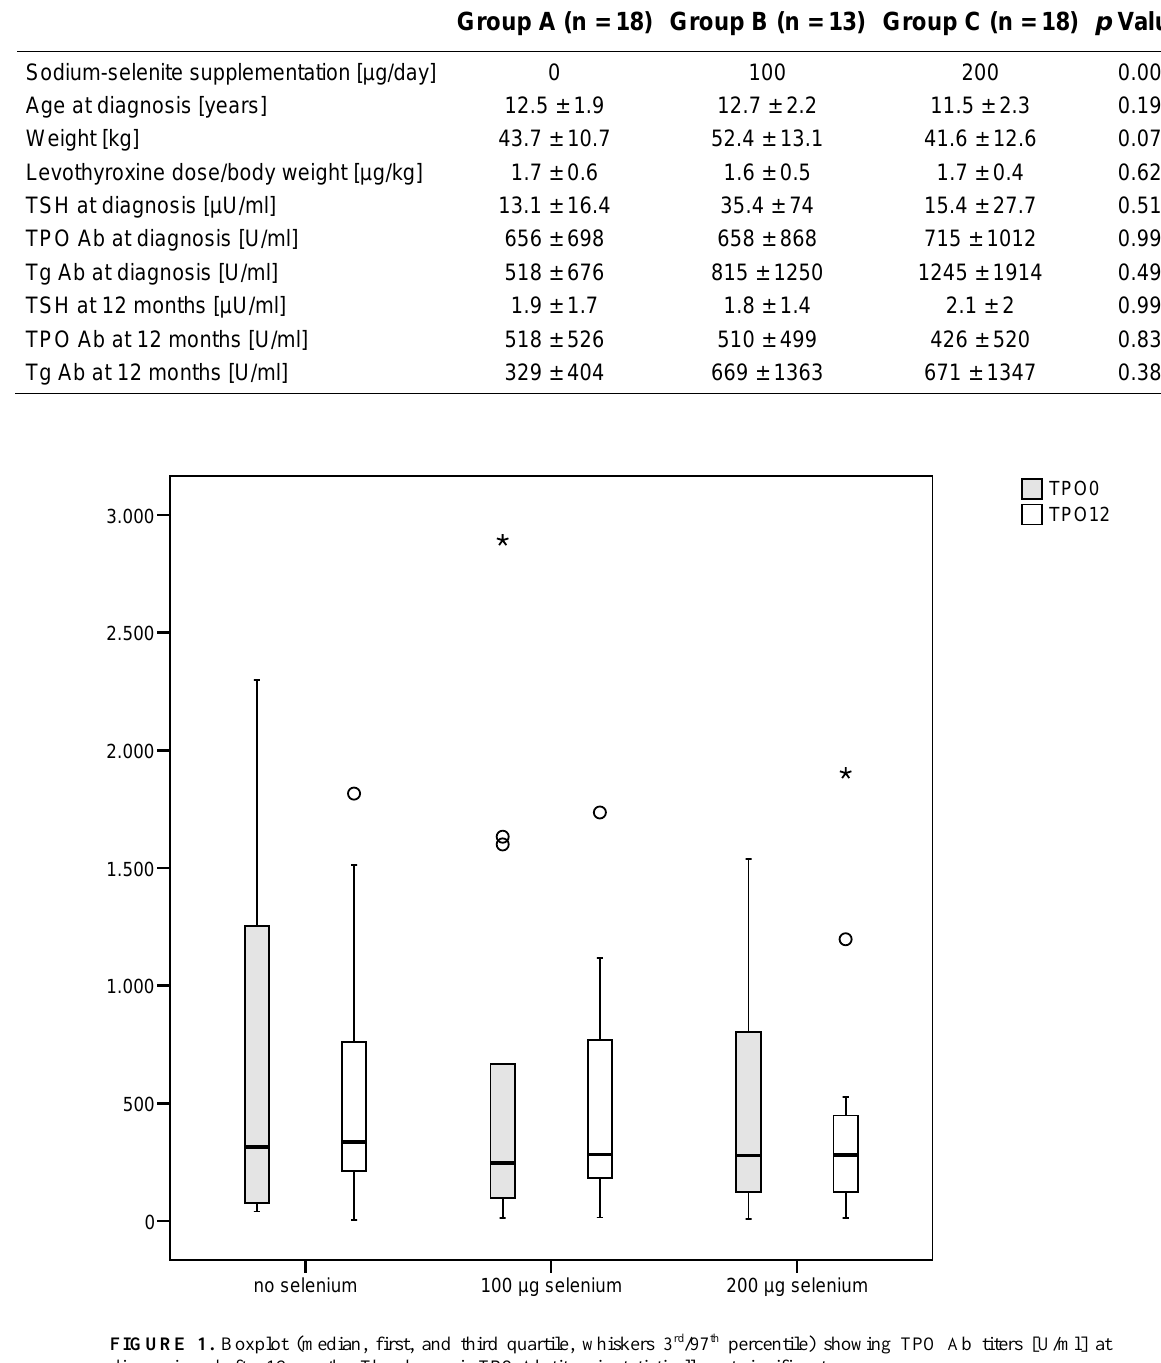
Results of the Three Different Treatment Groups (Mean ± SD)